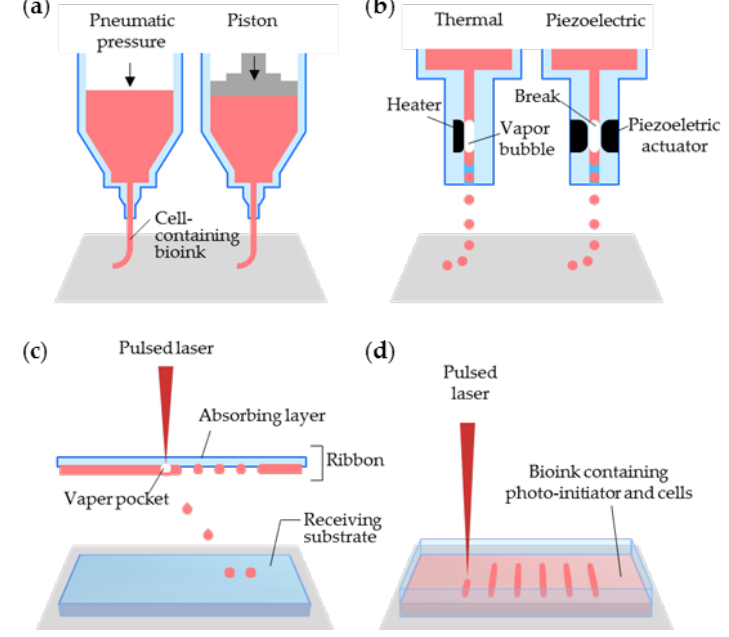
Figure 2. Schematics of 3D-cell printing methods with different working principles: ( a ) micro-extrusion, ( b ) inkjet, ( c ) laser-assisted printing, and ( d ) stereolithographic printing. Reproduced with permission from